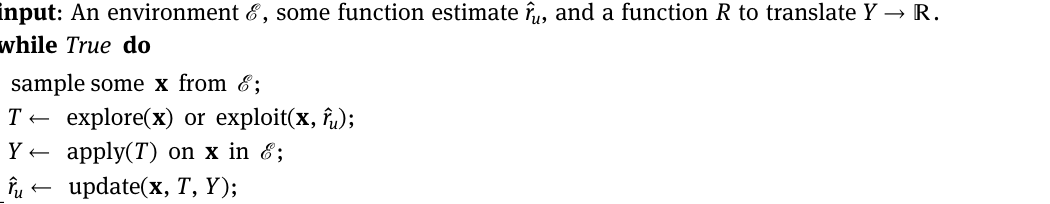
Algorithm 1 : General bandit with r ˆ